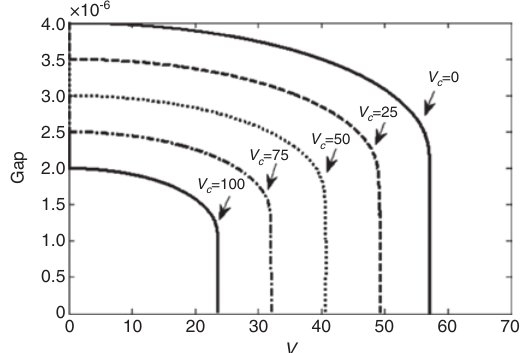
Figure 7 Gap variation between the FGM microgripper beam free ends for different ceramic volumes due to the initial temperature variation Δ T = 25 ° against the applied DC